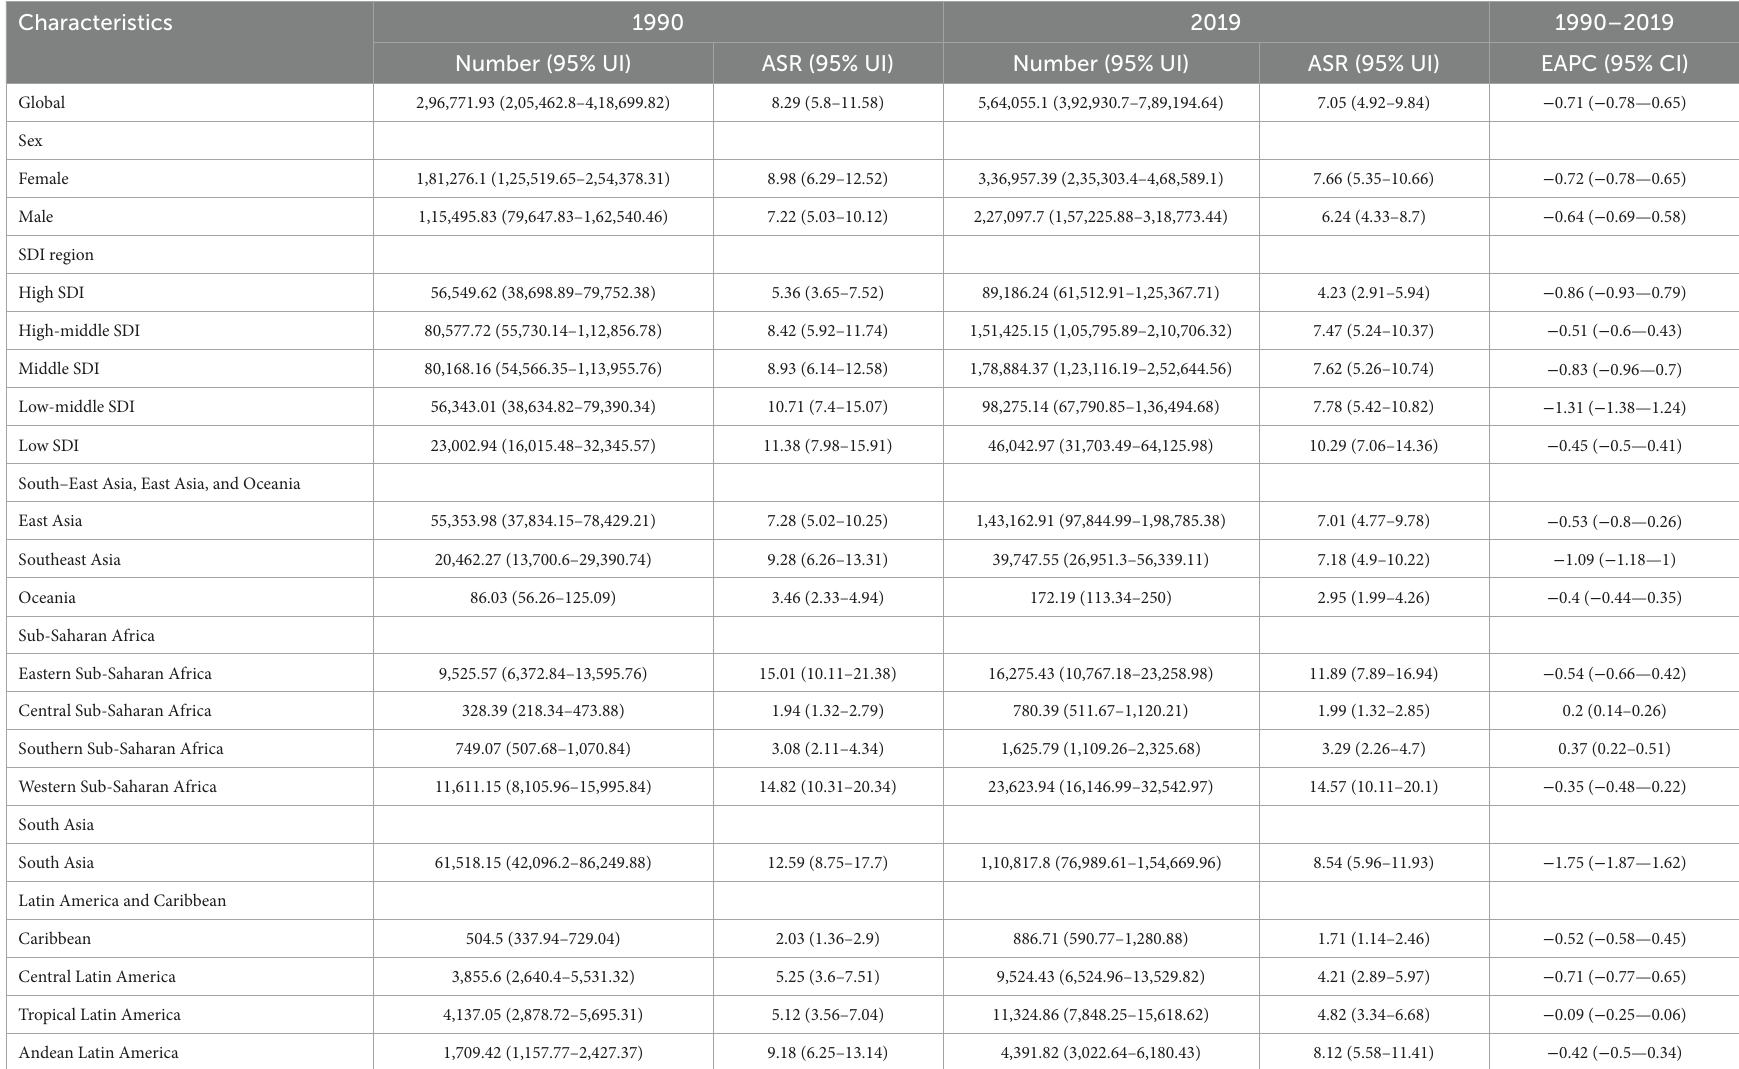
TABLE 2 Estimated number and age-standardized rate (per 100,000 persons) of YLDs and temporal trends for AMD from 1990 to 2019 by sex, SDI, and GBD regions.